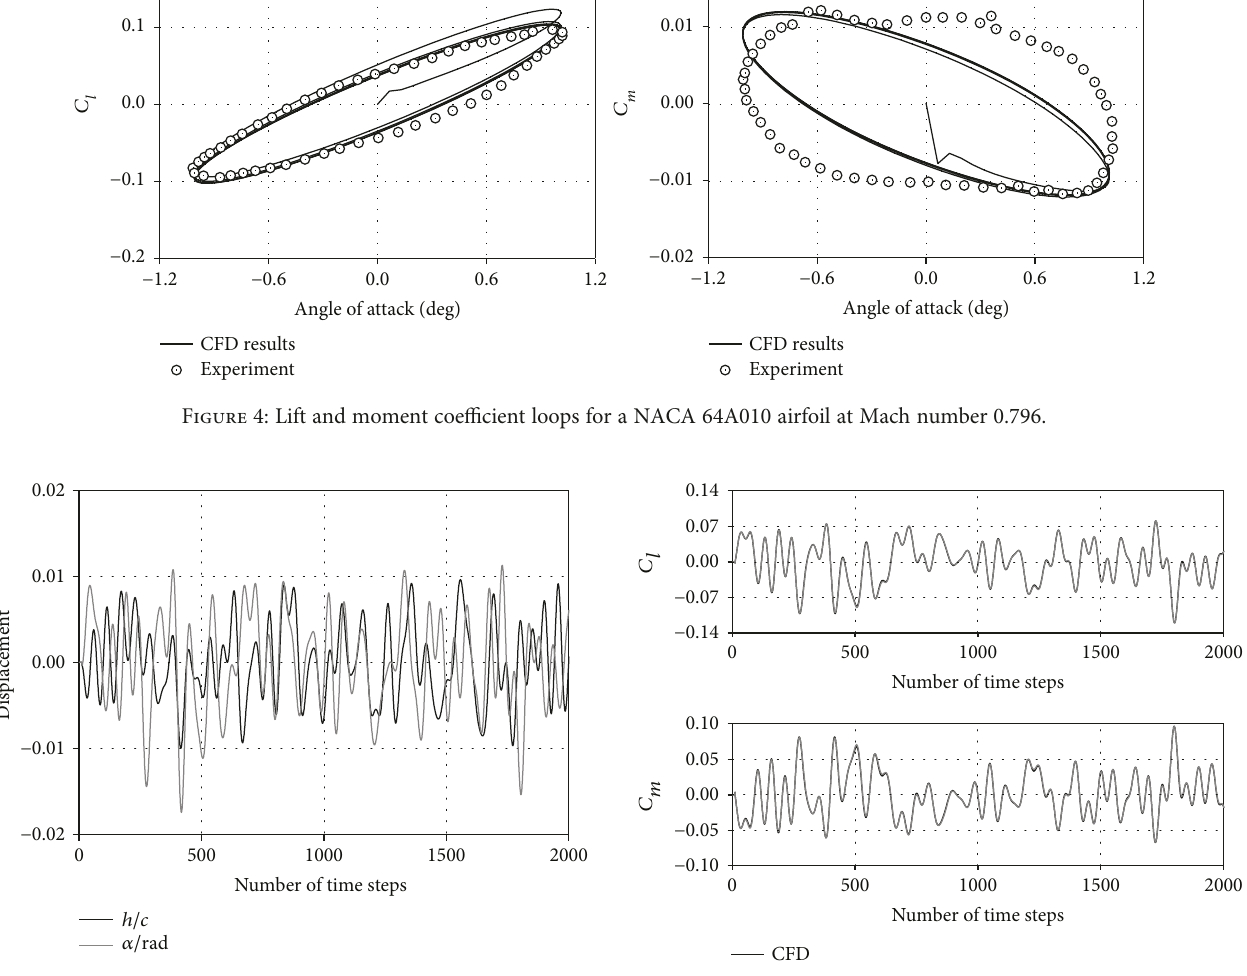
Figure 5: The FWGN excitation signals to drive pitch and plunge motions.